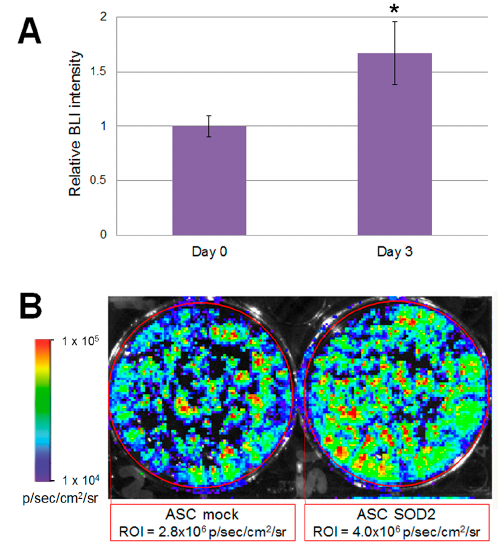
Figure 3. Luciferase positive SOD2 -expressing ASCs display improved ability to withstand hypoxia in vitro. Murine ASCs expressing luciferase were transduced with LV vectors expressing either GFP as mock control or SOD2 and cultured in hypoxic conditions. ( A ) BLI analysis was performed at three days of culture and intensity of bioluminescence was determined. Data are expressed as the ratio of the BLI signal of the SOD2 group vs. mock control group. Data are expressed as mean ± SEM of three different independent experiments performed in duplicate. The asterisk indicates a significant difference determined by unpaired Mann–Whitney U test ( p < 0.05); ( B ) A representative BLI analysis and quantification of ASCs cultured in hypoxic condition for three days.